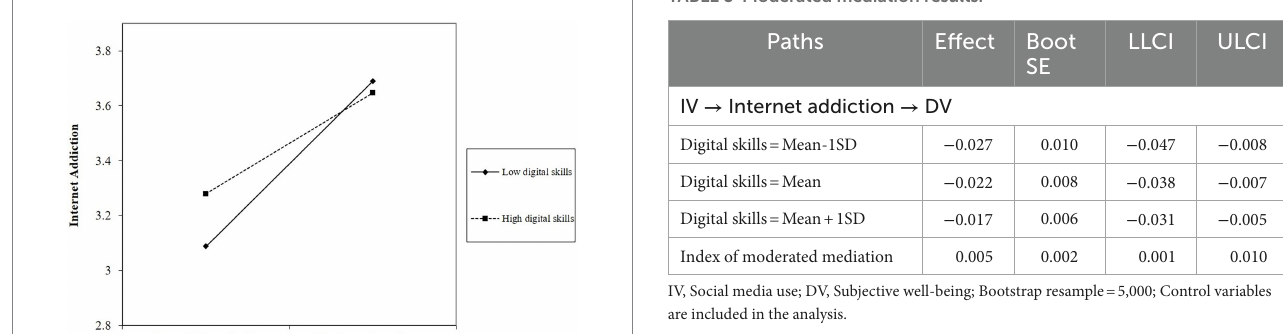
TABLE 5 Moderated mediation